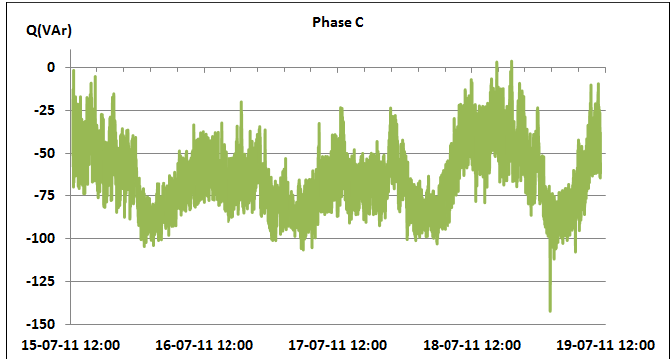
Figure 20. Reactive power of phase C for 15–19 July.